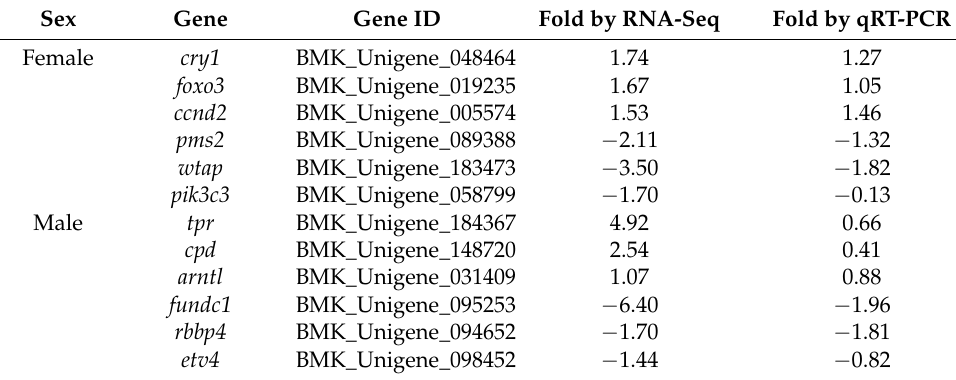
Table 1. Verification of differential expressed genes in G. rarus using qRT-PCR. Negative values indicate the down-regulation of expression, whereas positive values indicate the up-regulation of expression.